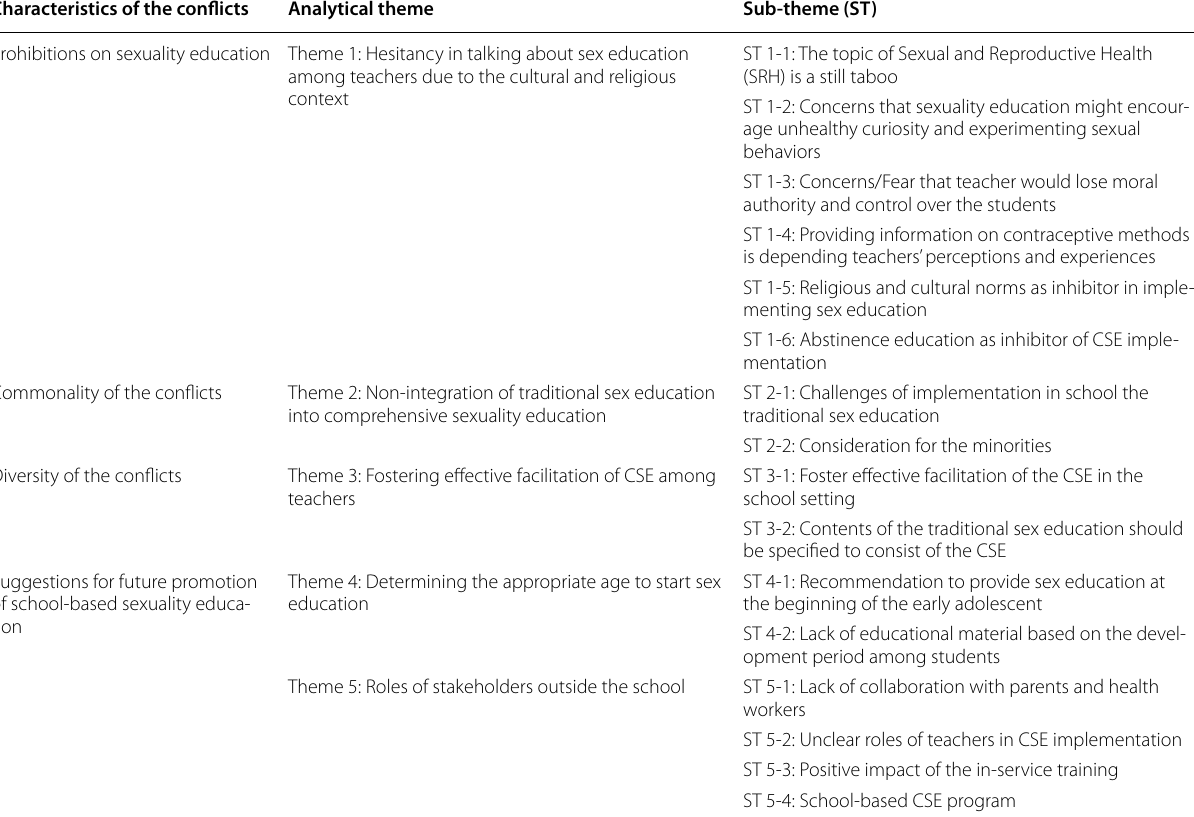
Table 6 Overview of the analysis of conflicts Characteristics of the